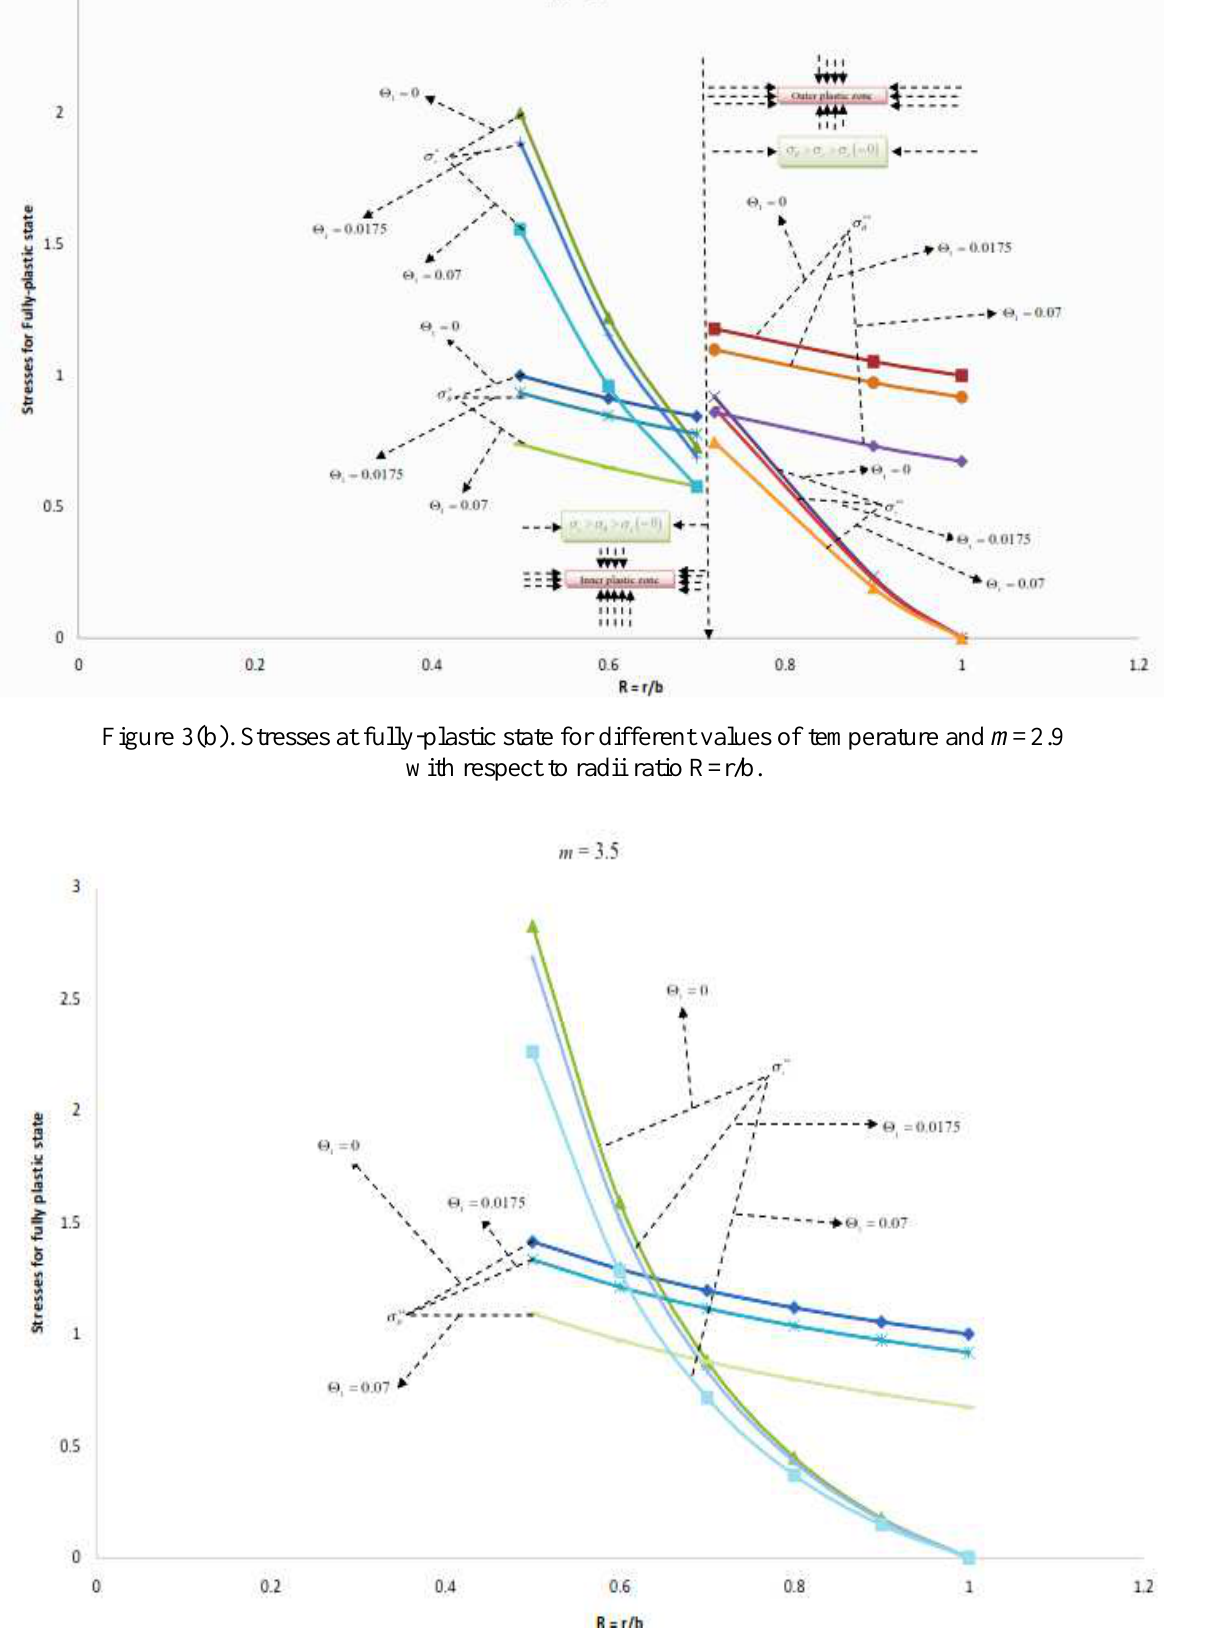
Figure 3(c). Stresses at fully-plastic state for different values of temperature and m= 3.5 with respect to radii ratio